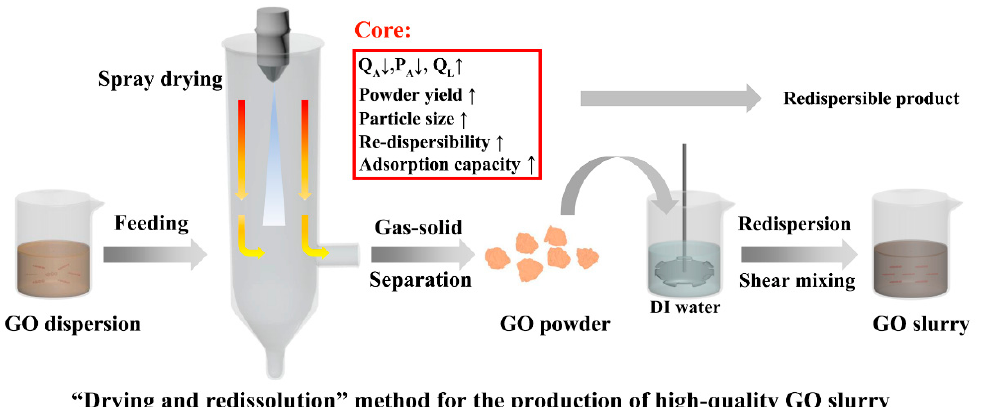
Figure 1. Graphic illustration of the “drying and redissolution” method for the production of high-quality GO